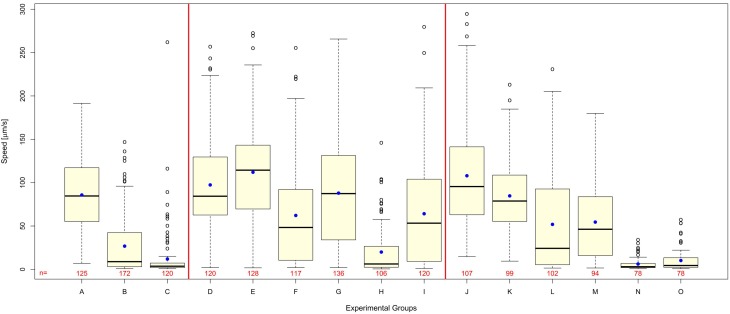
Polyvinyl alcohol reduces shock wave effect on C. elegans, whereas shock wave exposed C. elegans grown on NGM agar plates exhibit similar behavioral change to shock wave exposed C. elegans raised in liquid cultures. (A–C) Worms exposed to 0 (A), 100 (B), or 500 (C) shock waves in the main experiment of this study (these data are the same as those shown in Figure 2A and are displayed again here as a comparison only). (D–I) Worms exposed to 0 (D), 100 (F), or 500 (H) shock waves in S-Medium, compared to worms exposed to 0 (E), 100 (G), or 500 (I) shock waves in polyvinyl alcohol, a medium with low cavitation activity. Note that worms exposed to shock waves in polyvinyl alcohol demonstrated higher average worm speed than controls in S-medium (p < 0.001) immediately following application of shock wave. (J–O) Worms raised in liquid cultures and exposed to 0 (J), 100 (L), or 500 (N) shock waves in S-Medium, compared to worms grown on NGM agar plates and exposed to 0 (K), 100 (M), or 500 (O) shock waves. Note that shock wave exposure resulted in decreased speed of locomotion in both worms grown on NGM agar plates and worms raised in liquid cultures (p < 0.001). Medium of growth was not found to significantly affect speed of locomotion (p = 0.154), but the combined effect of medium of growth and shock wave exposure was found to be significant (p = 0.004). Horizontal lines within the boxes represent median speeds, dots within the boxes average speeds, and box and whiskers were plotted using the Tukey method. Positive-lying outlies are represented as individual points. It is of note that the high inter-individual variability reported in the main experiment (Figure 2) was neither specifically favored by one nature of medium in which worms were exposed to shock waves over another (S-Medium or polyvinyl alcohol) nor one culture media over another (S-medium vs. NGM agar plates). The numbers below the boxes indicate the numbers of worms per group.